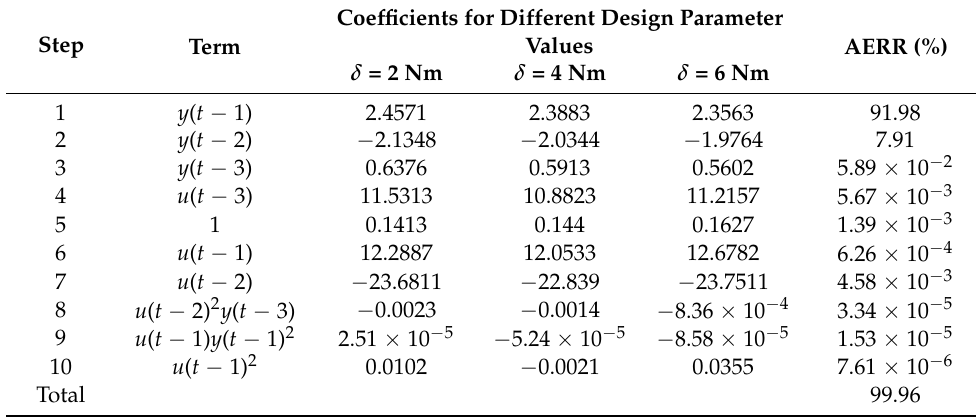
Table 3. The CMS of the bolted joint